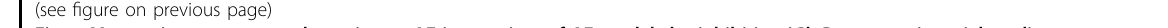
Fig. 1 Memantine prevents and terminates AF in a variety of AF models by inhibiting iGluR currents in atrial cardiomyocytes. a Representative ECG traces of AF episodes (top), and quanti fi cation of the incidence of AF in the vehicle group and memantine group in three in vitro rat AF models (bottom; * P < 0.05, calculated by Chi-squared test, n = 7 − 13 rats at each concentration). Vertical scale bar, 5 mV; horizontal scale bar, 400 ms. b Representative ECG traces of AF episodes (top), and quanti fi cation of the termination rate of AF in the vehicle group and memantine group in three in vivo rat AF models (bottom; * P < 0.05, calculated by Chi-squared test, n = 6 − 9 rats per group per AF model). Vertical scale bar, 1 mV; horizontal scale bar, 500 ms. c Representative traces of an iGluR current in rat atrial cardiomyocytes induced by a 1 mM glutamate puff under voltage clamping at − 60 mV (left). The bar graph showing iGluR current density in the vehicle group and memantine group (right; * P < 0.05, calculated by Student ’ s t -test, n = 10 − 14 cells per group). Vertical scale bar, 4 pA/pF; horizontal scale bar, 100 ms. d Typical traces of membrane potential in rat atrial cardiomyocytes treated with vehicle or 100 μ M memantine (left). Pooled data of the percentage of ACMs with DADs from the left (right; * P < 0.05, calculated by Chi-squared test, n = 15 − 18 cells per group). Vertical scale bar, 30 mV; horizontal scale bar, 250 ms. e Representative optical mapping of the rat atria, and quanti fi cation of the incidence of ectopic activity and reentry in the vehicle group and memantine group (* P < 0.05, calculated by Chi-squared test, n = 8 − 11 rats per group). f Representative fi eld potential traces of human iPSC-ACMs and quanti fi cation of the results (* P < 0.05, calculated by Chi-squared test, n = 32 per group). Vertical scale bar, 400 mV; horizontal scale bar, 1000 ms. g Representative membrane potential traces of DADs in single human iPSC-ACM and quantitative analysis of percentage of cells with DADs (* P < 0.05, calculated by Chi-squared test, n = 14 − 16 per group). Vertical scale bar, 50 mV; horizontal scale bar, 250 ms. Veh vehicle, Mem memantine, TAC transverse aortic constriction, Glu glutamate, ACMs atrial cardiomyocytes, SVC superior vena cava, IVC inferior vena caca, LA left atrium, RA right atrium, SAN sinoatrial node, DADs delayed